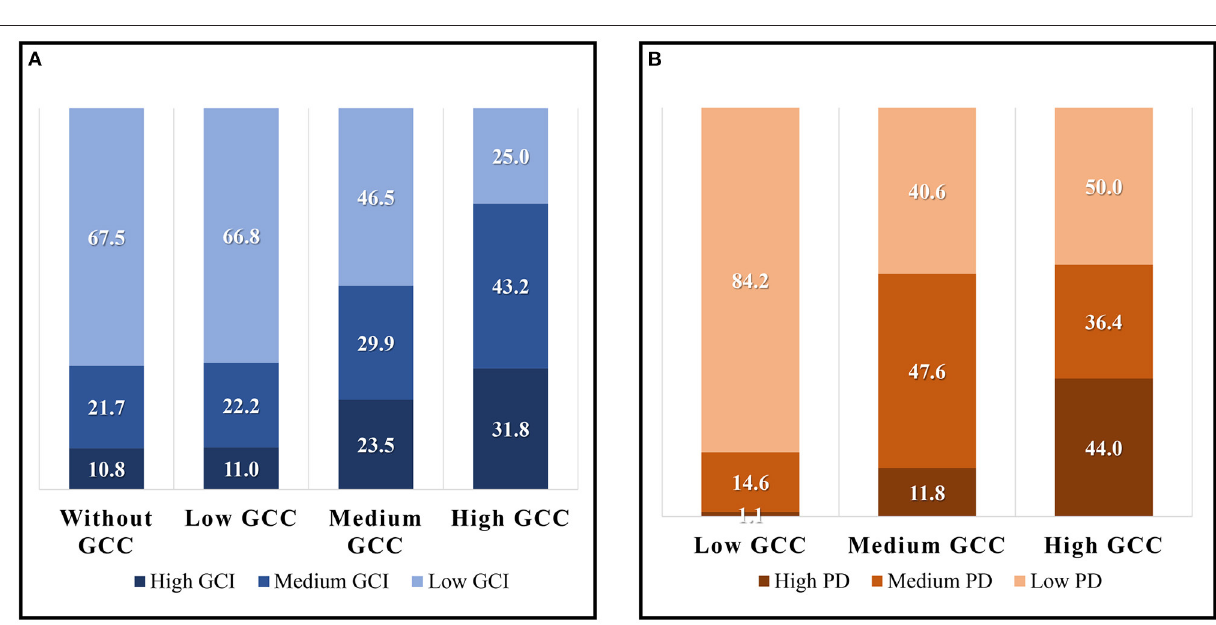
GCC according to the Natural Breaks (Jenks) method ( Figures 7A , 8